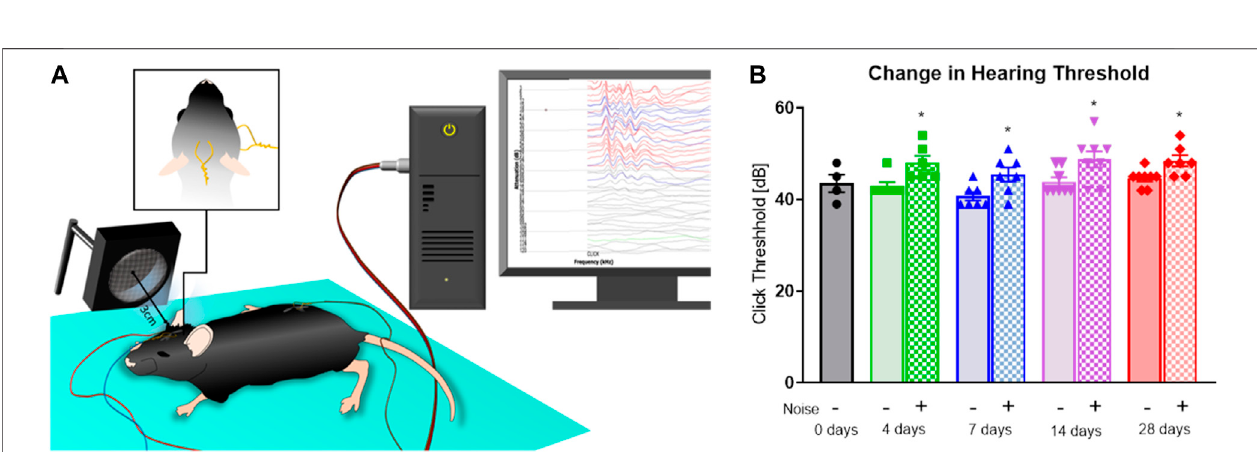
FIGURE8| Noise-inducedchangesinhearing threshold. (A) ABRtesting wasused toevaluate thepossibilityofnoise-inducedhearing damageover thecourse of the noise treatment. The ABR method records the brainstem response to an auditory stimulus in an anesthetized animal using the depicted setup and device. (B) Baseline hearing thresholdswereconsistent,withanapparentrisethatwaspresentafter only 4days ofnoisetreatment and appeared toslightlyreduce inseverity.Data are mean ± SEM. Statistical analysis with one-way ANOVA with Tukey ’ s multiple comparison test. Points are measurements from individual animals, n (cid:1) 4 – 8. p < 0.05: * vs respective unexposed group at same time